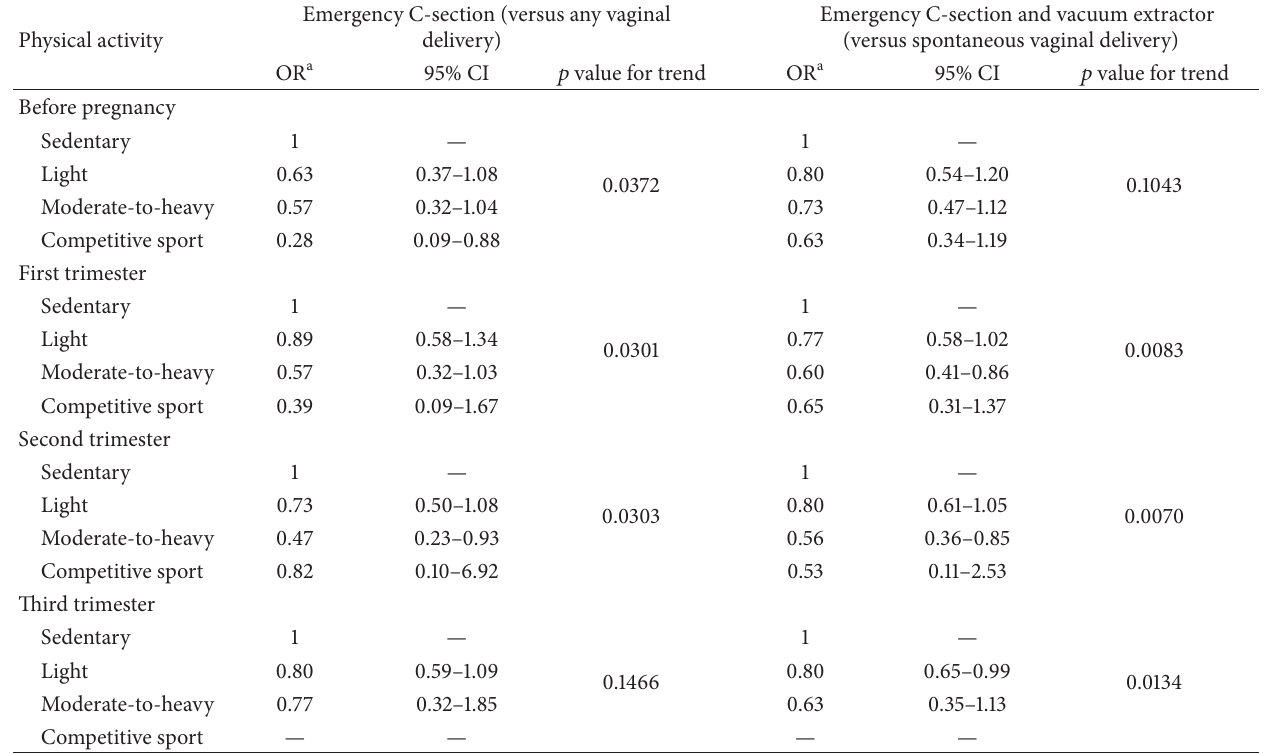
Table 3: Adjusted odds ratios for mode of delivery according to leisure time physical activity before and during pregnancy. The Danish Dystocia Study. 𝑁 = 2435 .